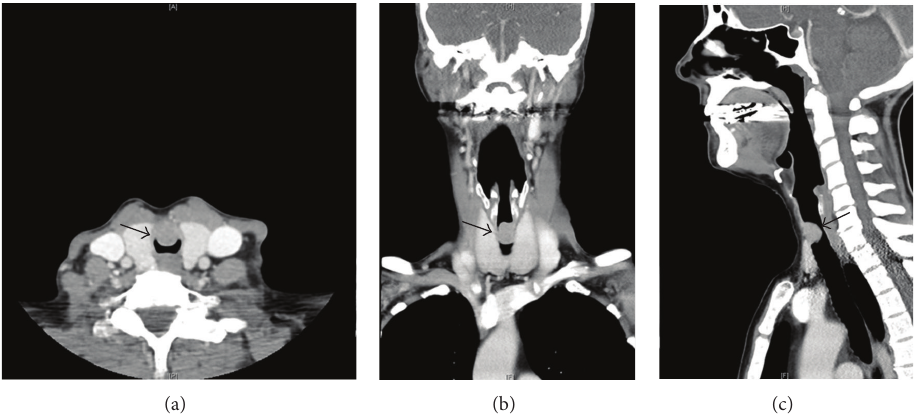
Figure 2: (a) CT neck with intravenous contrast in axial plane, (b) coronal plane, and (c) sagittal plane demonstrating a 1.3 × 1.4 × 1.9 cm round soft tissue mass (arrow) extending posteriorly from the anterior wall of the upper trachea at the level of C6, approximately 2cm inferior to the true vocal cords associated with significant ( > 80%) airway obstruction.